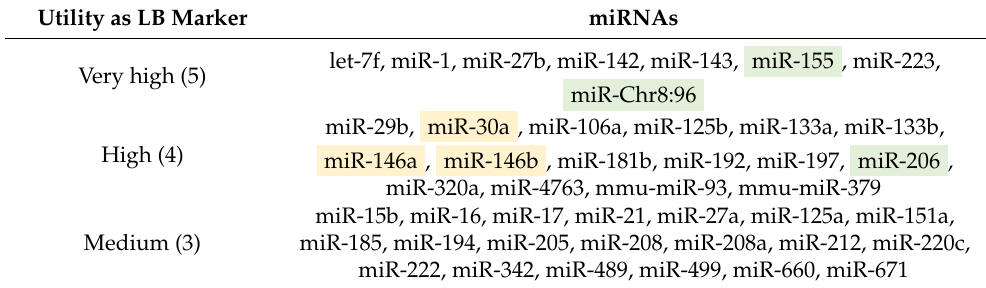
Table 5. Results of screening.